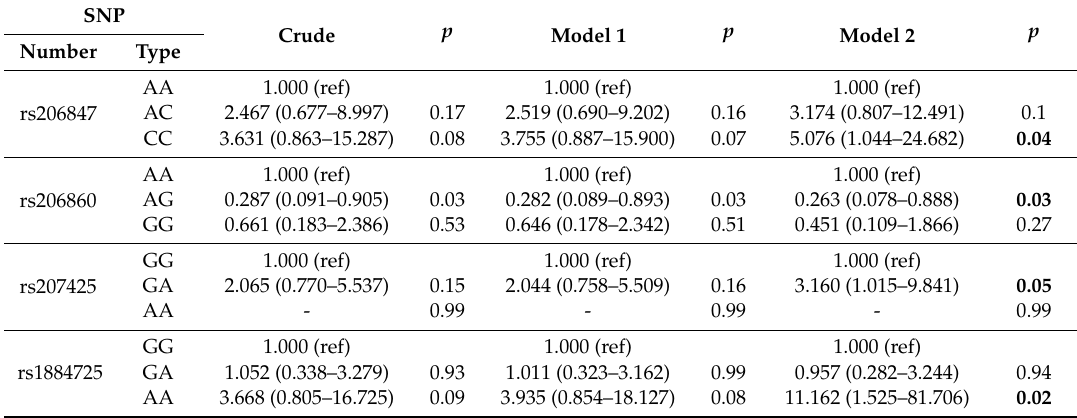
Table 4. Association of XDH genetic variants and risk of